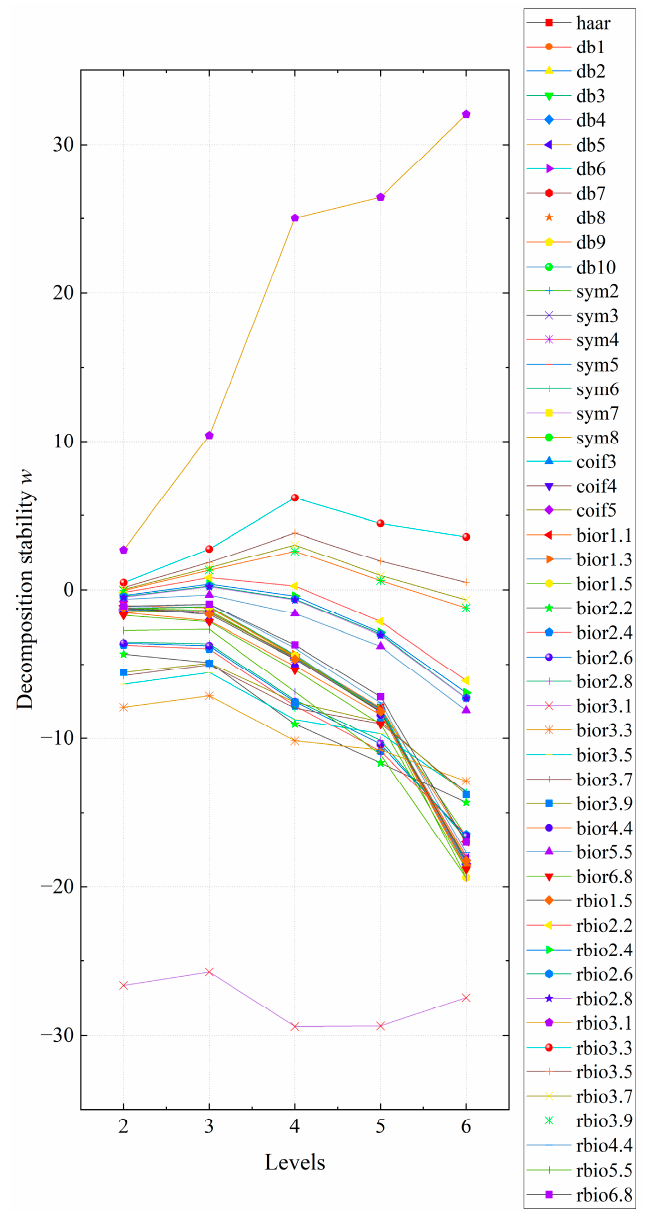
Figure 9. When calculating w , the influence of different wavelet packet decomposition levels.